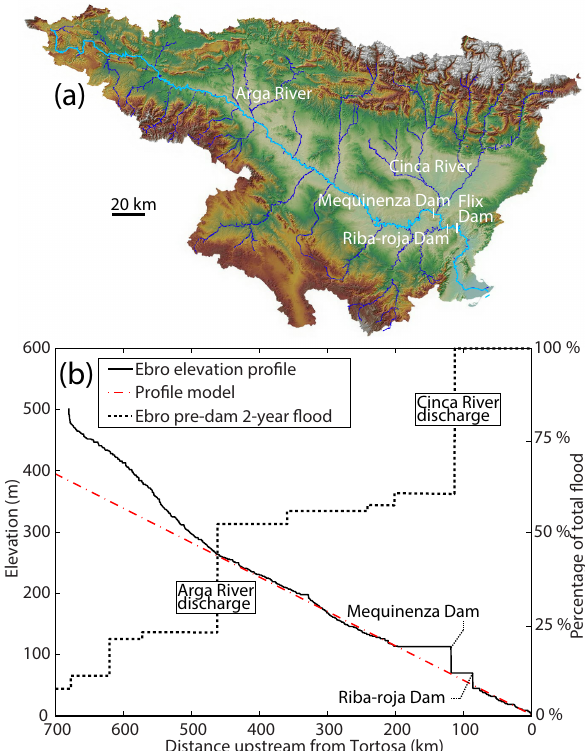
Figure 5. (a) The Ebro River basin showing the main river channel in light blue and larger tributaries in darker blue, colored by eleva- tion. (b) The elevation profile of the Ebro River, with the equilib- rium profile model prediction in red dashed line. The black dashed line shows the cumulative fraction of the Ebro pre-dam discharge from Batalla